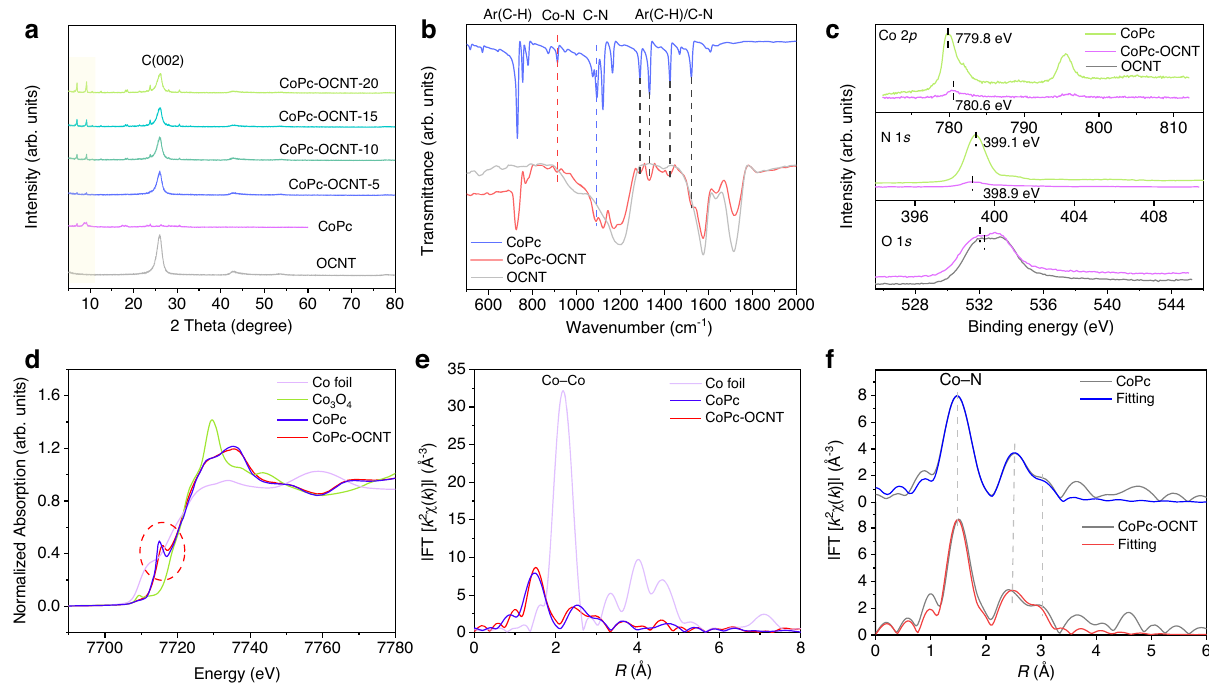
Fig. 2 | Characterizations ofCo sites in the CoPc-OCNT catalyst. a XRD patterns of CoPc-OCNT with different Co loadings. b FT-IR spectra of OCNT, CoPc-OCNT and CoPc reference. c Co 2 p , N 1 s and O 1 s high-resolution XPS spectra of CoPc-